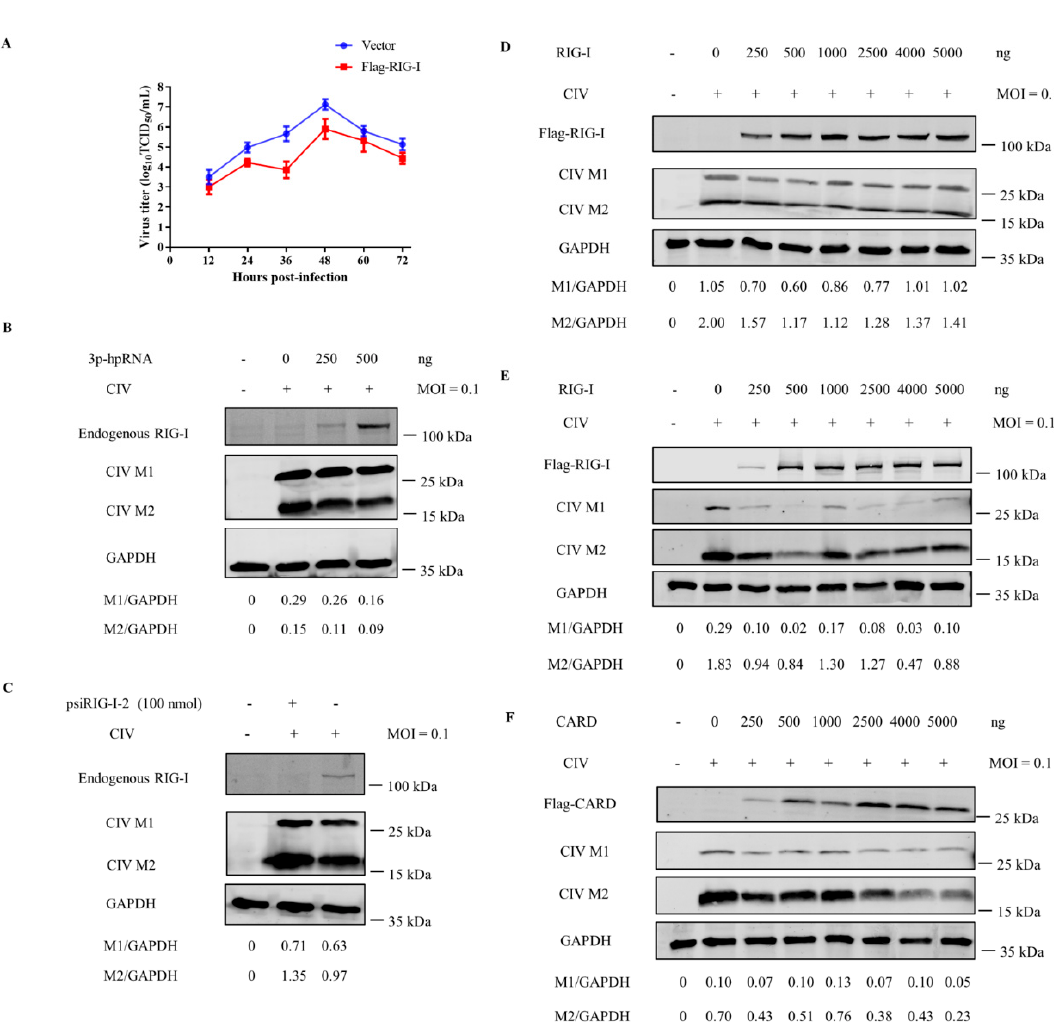
Figure 5. RIG-I inhibits the replication of CIV. ( A ) CIV H3N2 growth kinetics monitored over 72 h in MDCK cells transfected with Flag–RIG-I or empty vector. ( B , C ) MDCK cells were transfected with indicated concentrations of RIG-I agonist ( B ) or psiRIG-I-2 ( C ); after 24 h, cells were inoculated with CIV H3N2 at 0.1 multiplicity of infection (MOI) and the expression level of the endogenous RIG-I, viral M1 and M2 was determined by western blotting with GAPDH used as a loading control. ( D ) MDCK cells were transfected with indicated concentrations of Flag-RIG-I plasmid, after 24 h, cells were inoculated with CIV H3N2 at 0.1 MOI and the expression level of the Flag tagged RIG-I, viral M1 and M2 was determined by western blotting with GAPDH used as a loading control. ( E , F ) HEK 293T cells were transfected with Flag-RIG-I ( E ) or Flag-CARD ( F ) plasmids; after 24 h, cells were inoculated with CIV H3N2 at 0.1 MOI and the expression level of the Flag tagged RIG-I, Flag tagged CARD, viral M1 and M2 was determined by western blotting with GAPDH used as a loading control. Protein band intensity of endogenous RIG-I, Flag tagged RIG-I and CARD, viral M1 and M2, and GAPDH were used for western blotting quantification